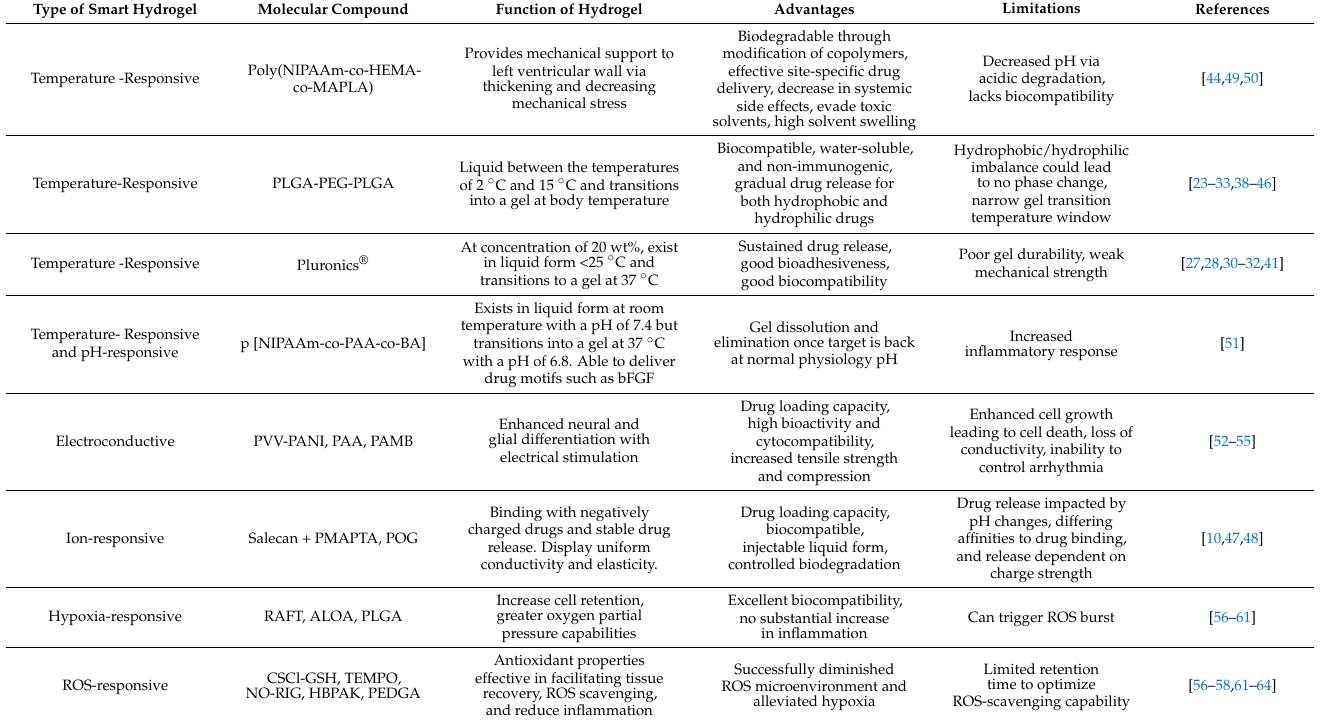
Table 1. Overview of the commonly used stimuli-responsive